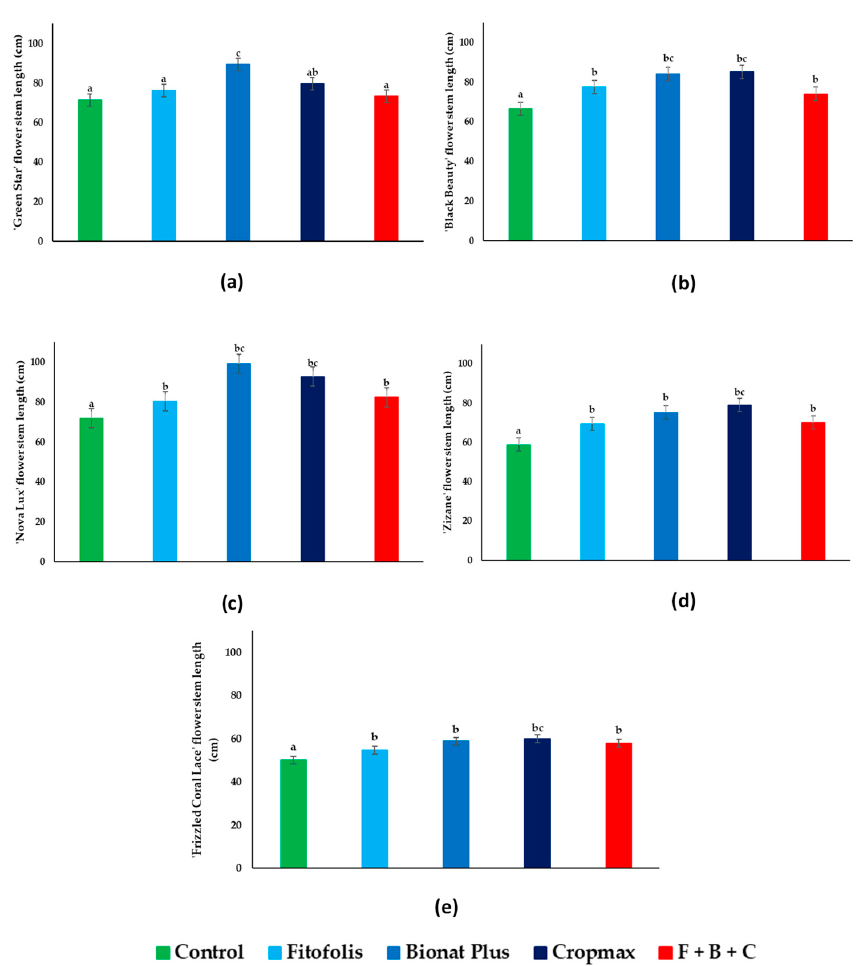
Figure 2. Effect of foliar fertilization on flower stem growth parameters in Gladiolus varieties: ‘Green Star’ ( a ), ‘Black Beauty’ ( b ), ‘Nova Lux’ ( c ), ‘Zizane’ ( d ), and ‘Frizzled Coral Lace’ ( e ). Plant